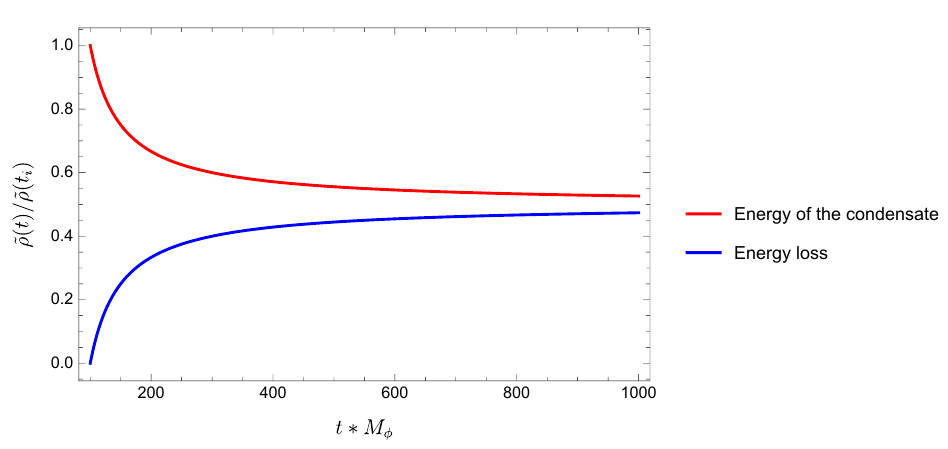
Figure 15 . Energy transfer from the condensate to the produced particles in a matter-dominated universe without the self-energy correction. The evolution of the condensate comoving energy density and of the energy loss are drawn in the red and blue lines, respectively. Comparing with figure 2, the energy transfer from the condensate to the produced particles in a matter-dominated universe is inefficient if the γ dissipation is